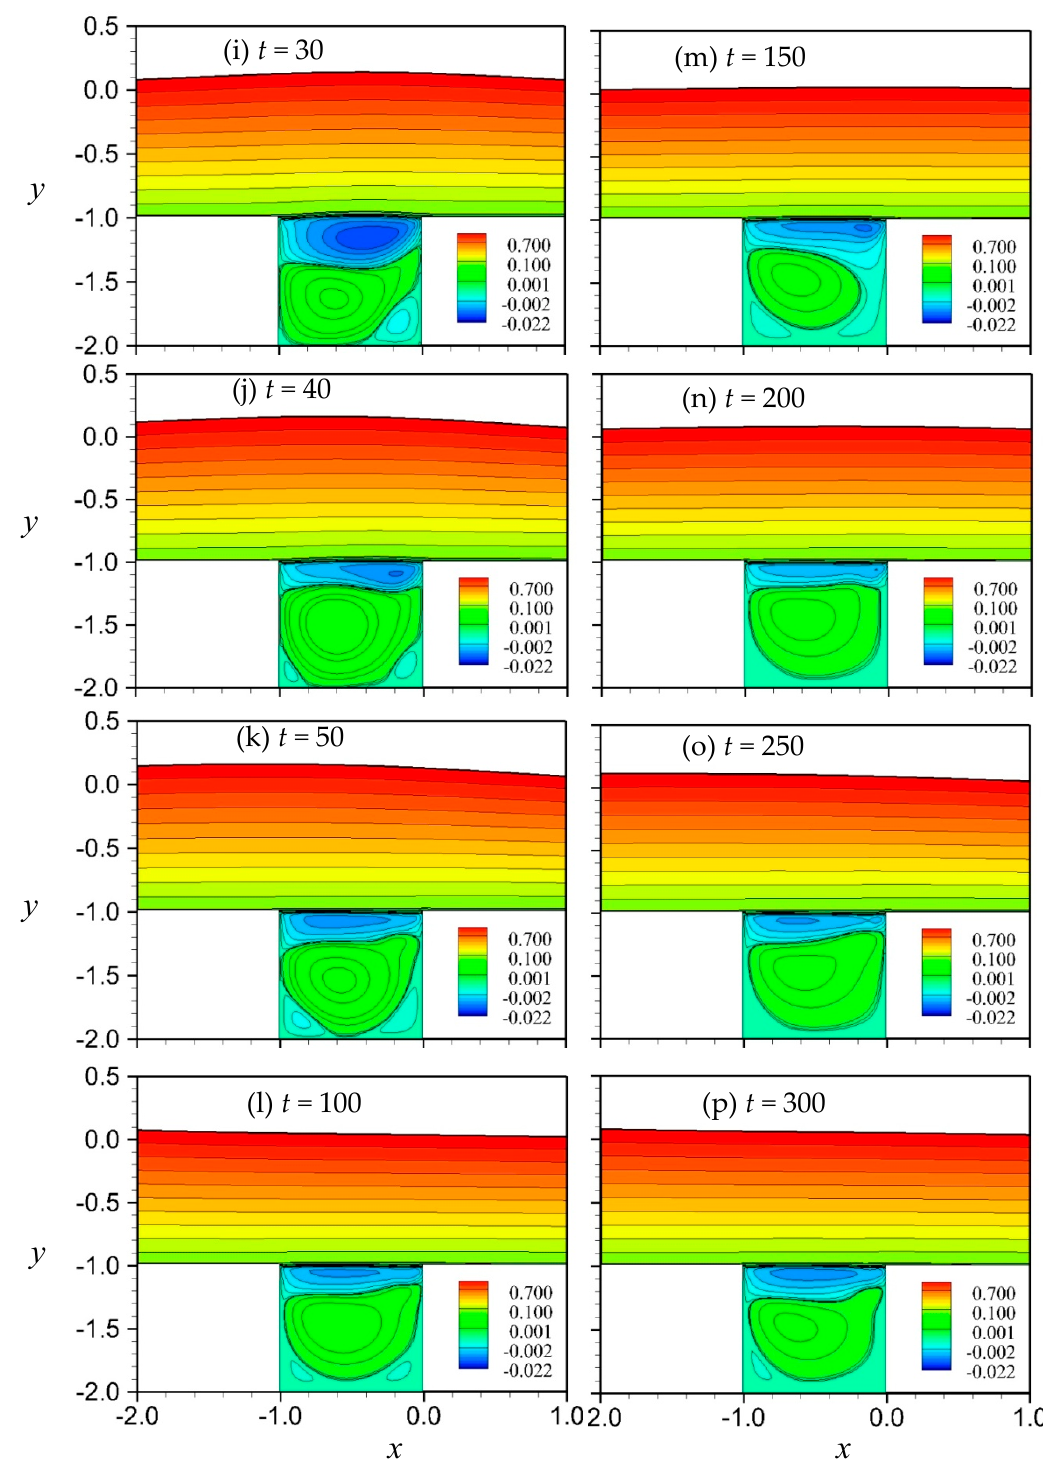
Figure 9. Streamline patterns in a square cavity for Re = 5000 and Fr = 1.0 at various phases: ( a ) t = 0.4, ( b ) t = 0.8, ( c ) t = 2, ( d ) t = 4, ( e ) t = 8, ( f ) t = 13, ( g ) t = 17, ( h ) t = 19, ( i ) t = 30, ( j ) t = 40, ( k ) t = 50, ( l ) t = 100, ( m ) t = 150, ( n ) t = 200, ( o ) t = 250, and ( p ) t = 300.